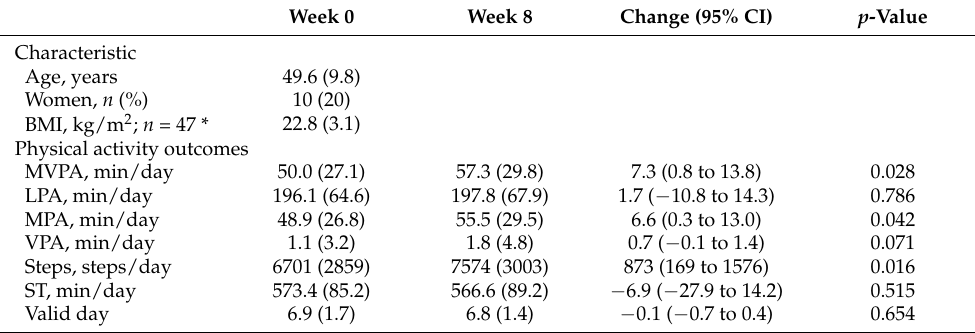
Table 2. Physical activity outcomes during the intervention program ( n =